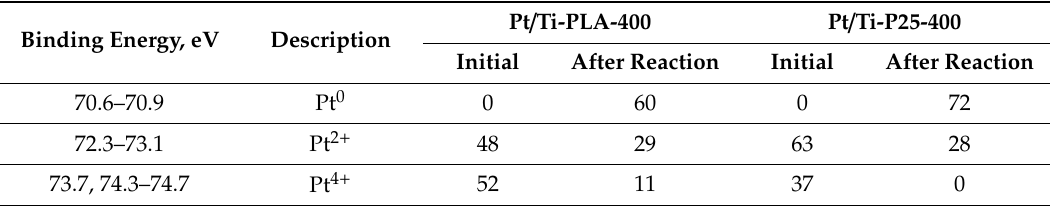
Figure 12. Curve fitted Pt4f spectra of ( a ) Pt / Ti-PLA-400 and ( b ) Pt / Ti-P25-400 catalysts before (BR) and after their exposure to reaction medium (AR). The spectra of the catalysts before catalytic experiments are given to allow comparison with the spectra obtained after the catalytic cycle. Table 4. Relative distributions of platinum forms in the catalysts (as a percentage to the total amount of platinum) in the samples before and after exposure to the reaction medium.